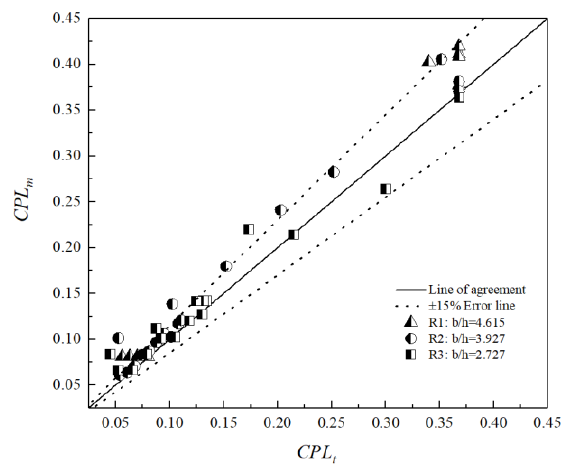
Figure 6. Comparison of the CPL between the theoretical and measured values in a rectangular channel.